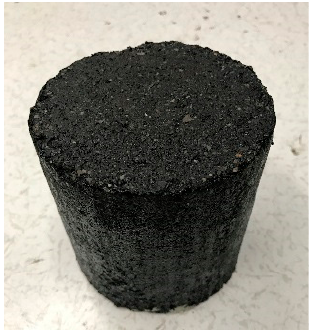
Figure 4. Micro surfacing material specimen.